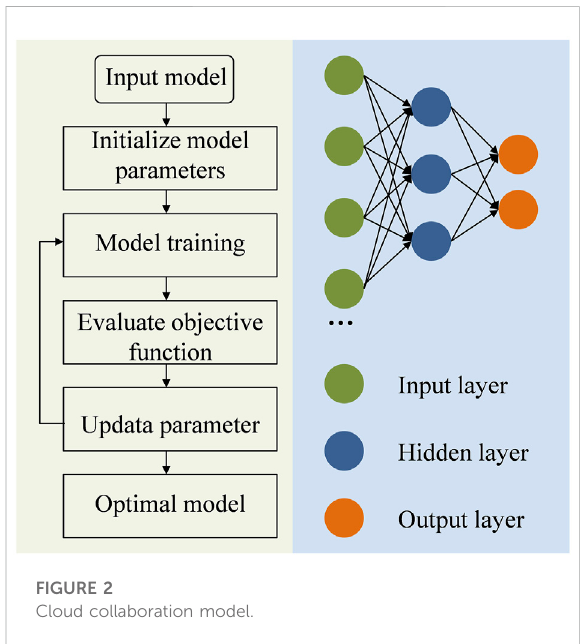
FIGURE 2 Cloud collaboration model.